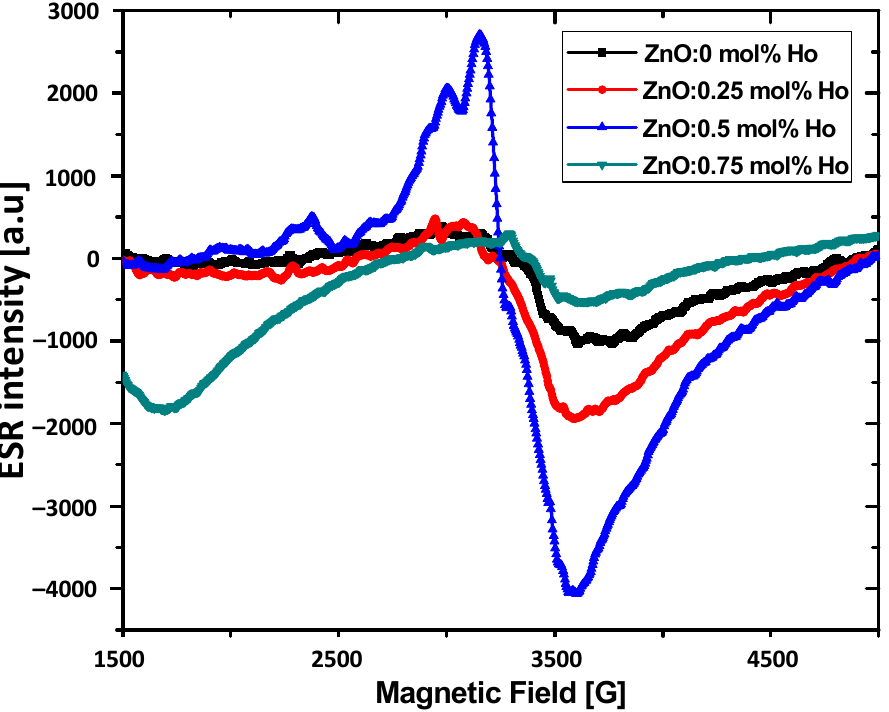
Figure 7. X-band (9.4 GHz) ESR spectra for un-doped and Ho 3+ -doped ZnO samples at room tem- perature.